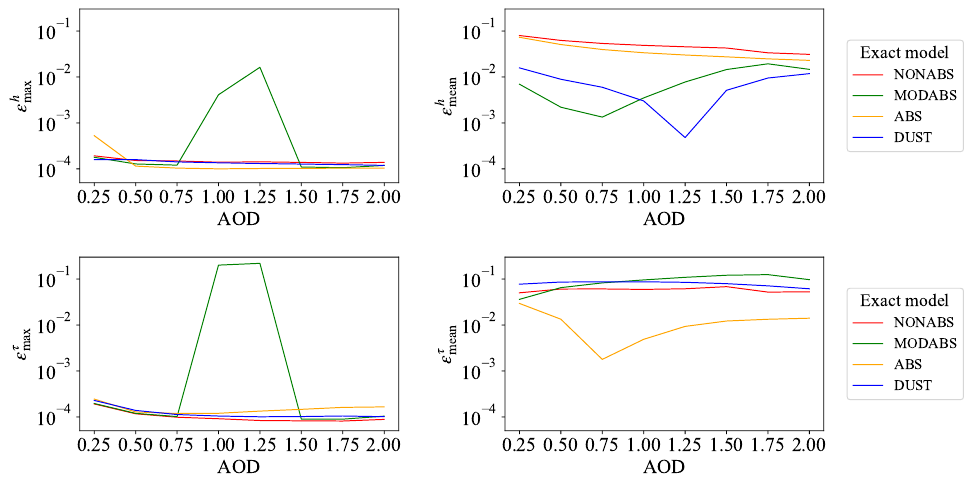
Figure 2. Relative errors ε τ , h mean,max ( τ e , h e = 3.5 km ) for the aerosol models from Set 1. AOD represents the aerosol optical